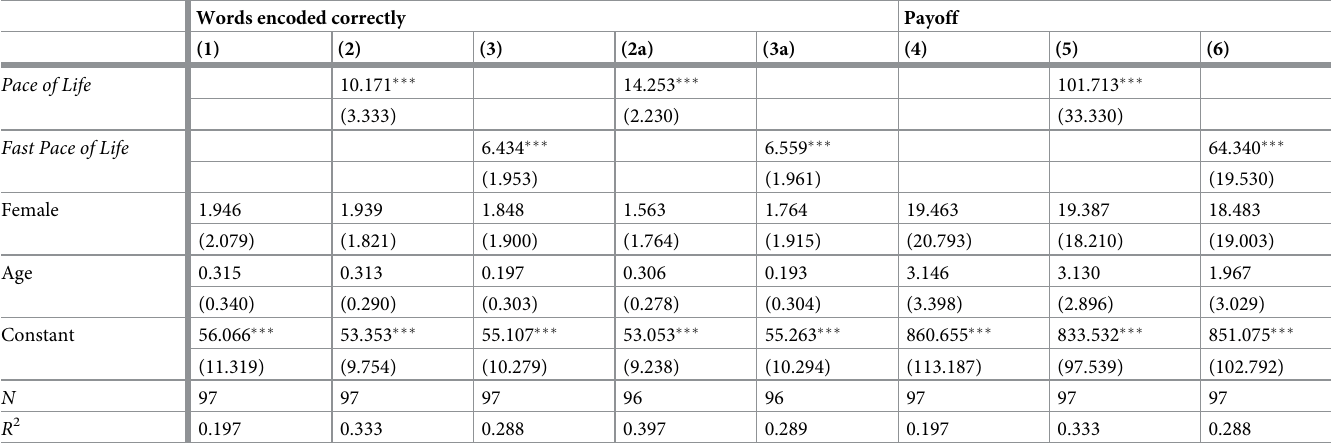
Table 2. Regression results for achievement. Words encoded